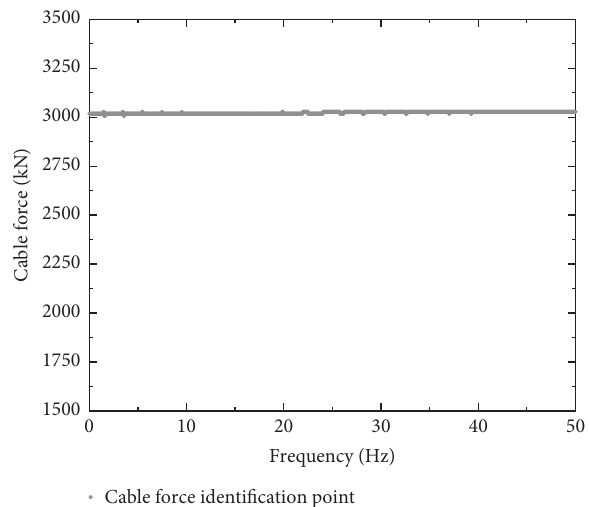
Figure 17: Recognition result after updating the bending